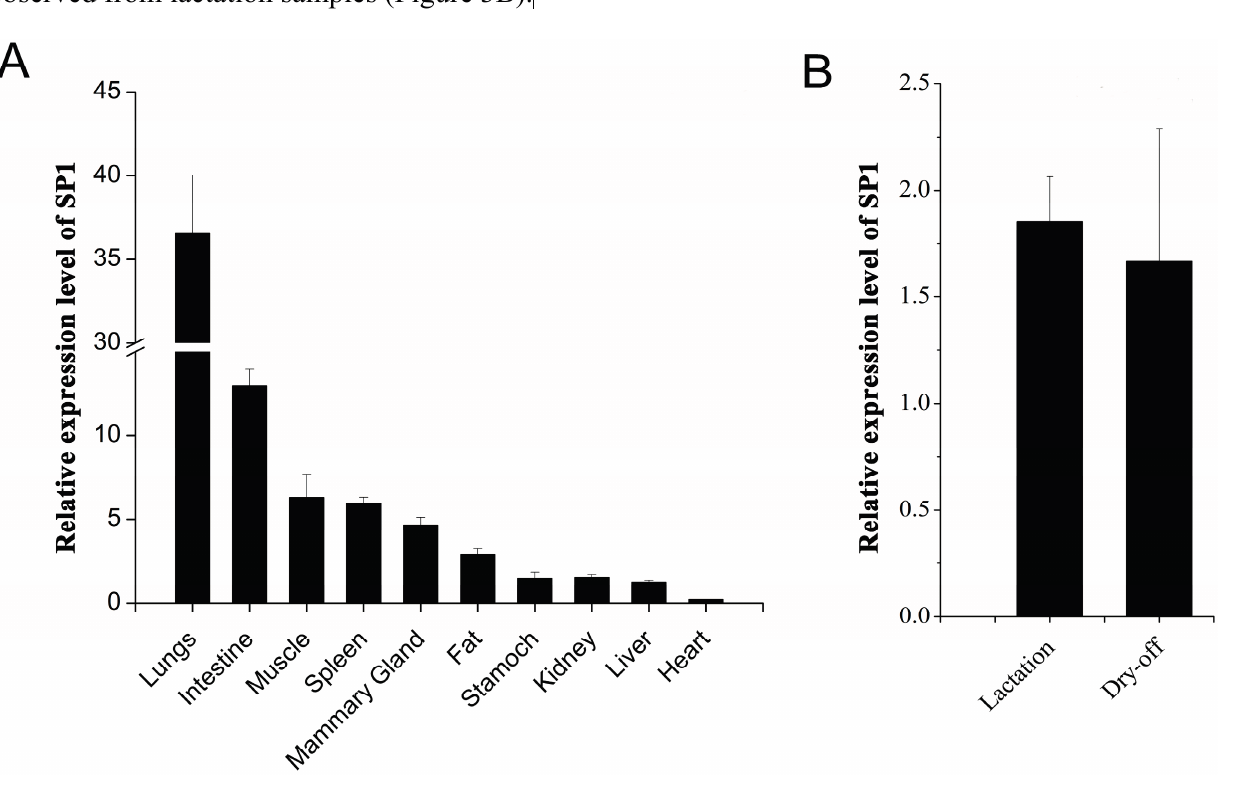
Figure 3. The mRNA expression profiles of SP1 . ( A ) mRNA expression of SP1 in various tissues in dairy goats; ( B ) Expression level of SP1 between lactation and dry-off